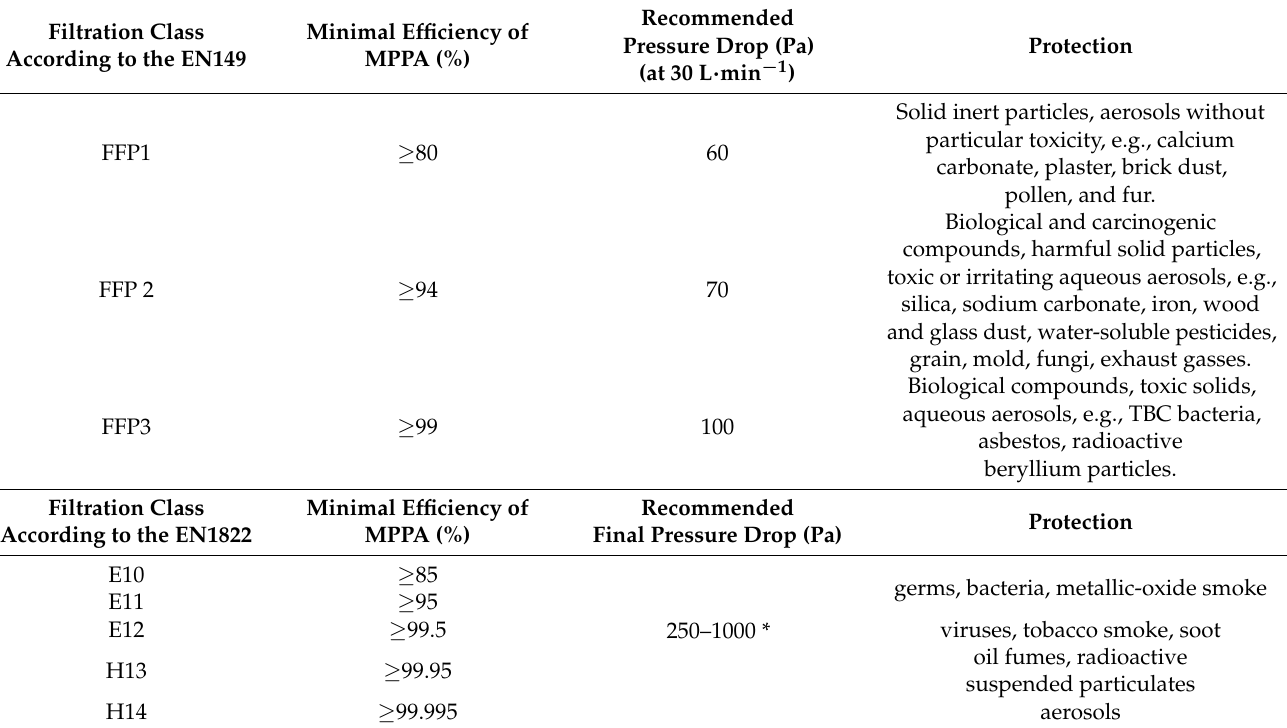
Table 5. Division of respiratory protection into classification according to standard EN149 and EN1822, minimum efficiency of safety, maximal acceptable pressure drop at the total volume flow 30 L · min − 1 , and examples of protection